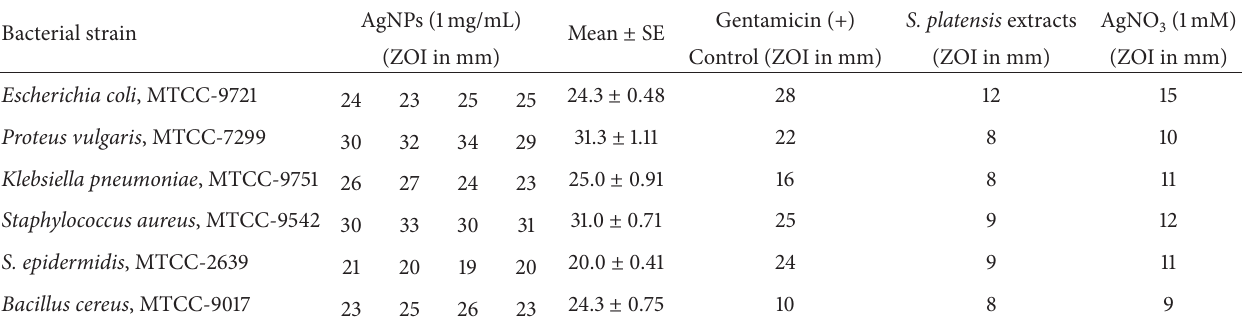
Table 1: Antibacterial activity of AgNPs.